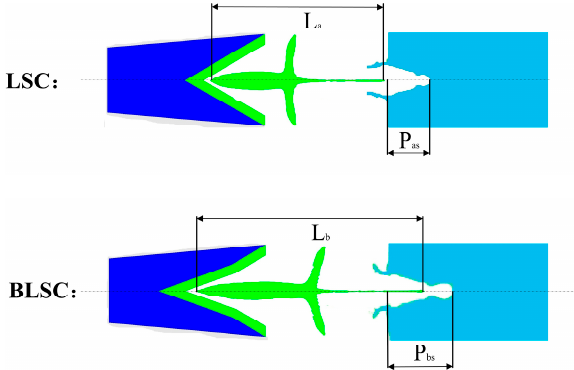
Figure 9. Numerical simulation of jet formation and penetration processes. Table 3. Parameters of material model.